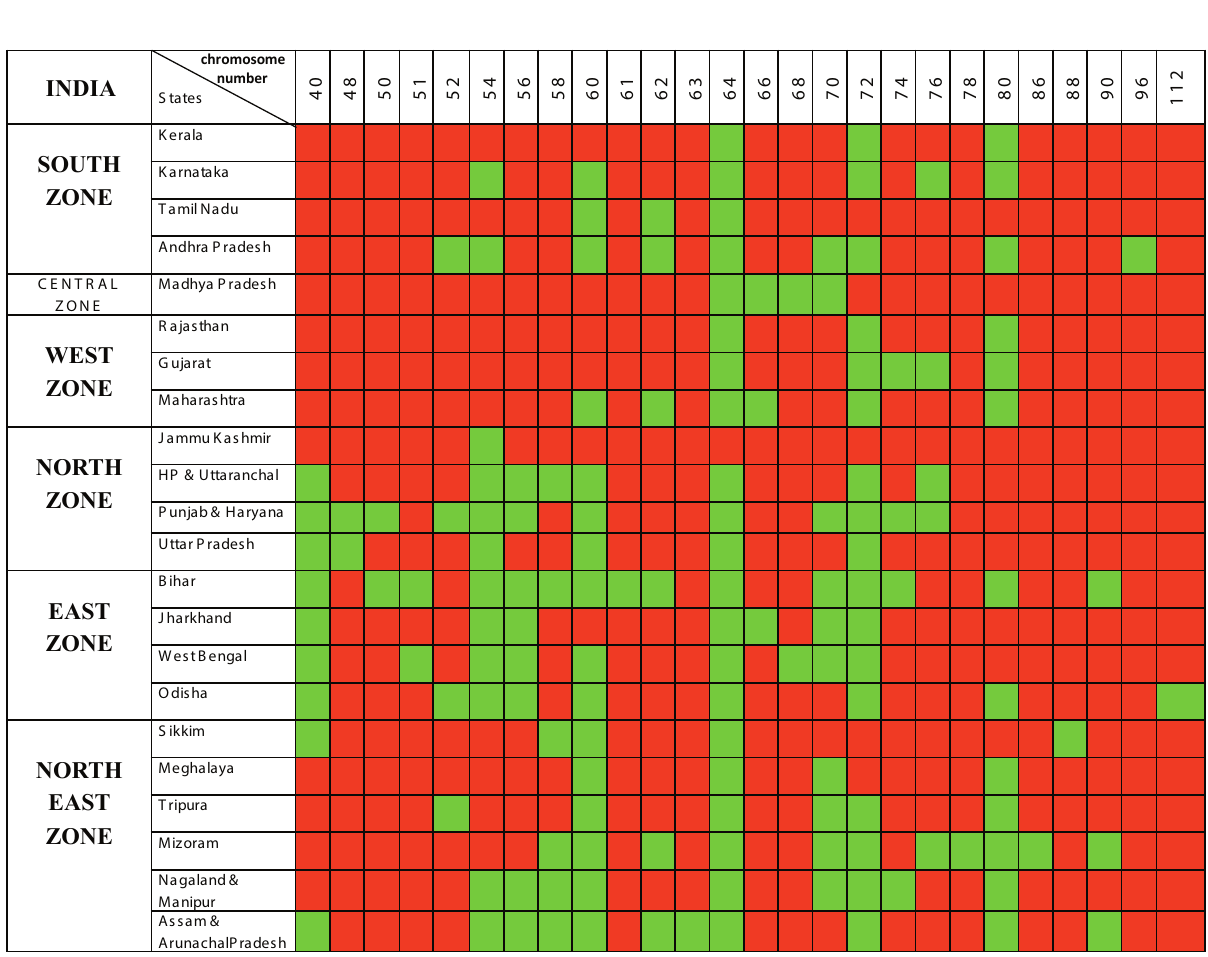
Figure 4. Distribution pattern of S. spontaneum cytotypes in different geographic zones of